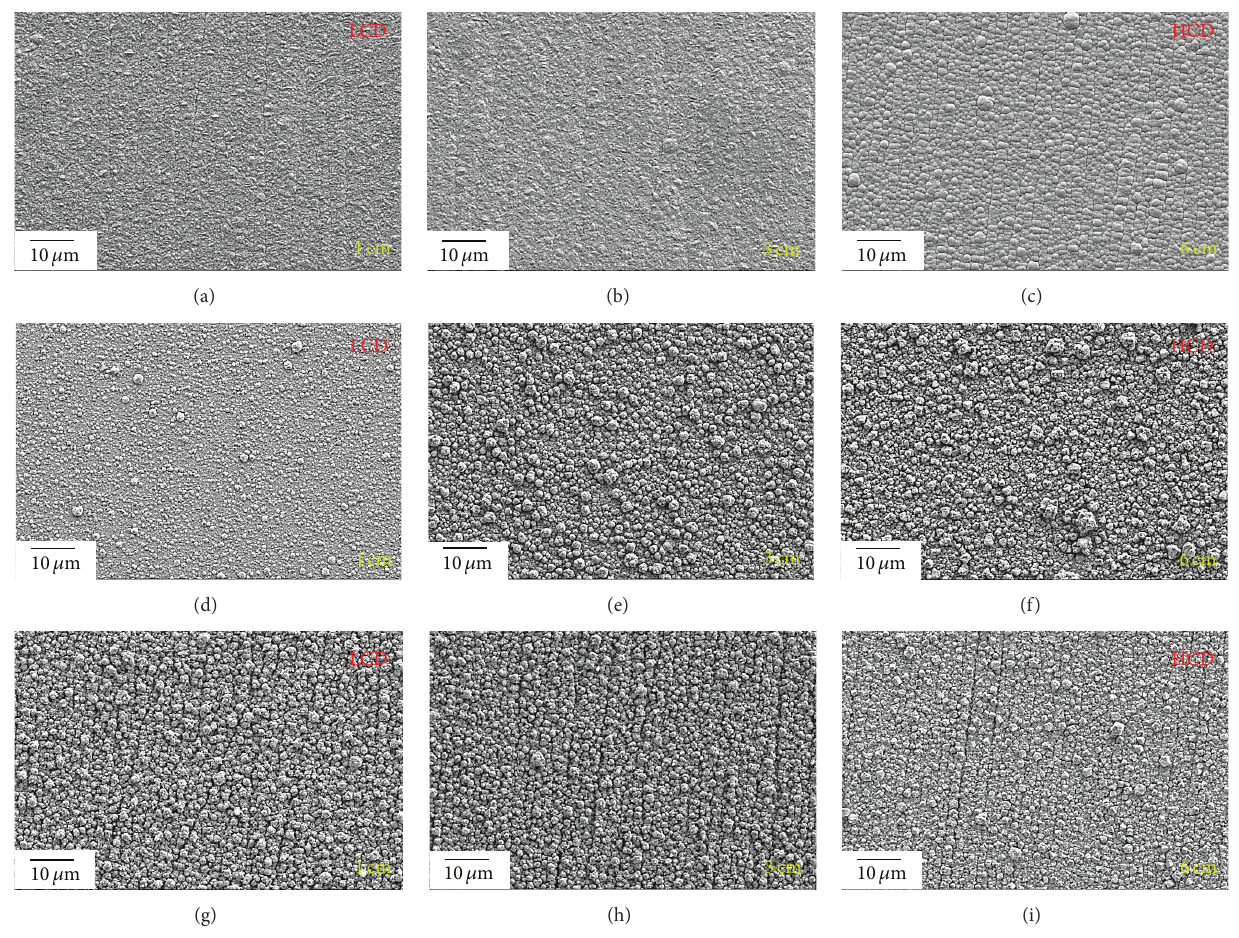
Figure 13: SEM micrographs taken at different regions on the substrate: 1cm, 3 cm, and 6cm showing the surface morphology of the electrodeposited Cu film fabricated at 2 mAcm −2 (a)–(c); 4.1mAcm −2 (d)–(f); and 8.2 mAcm −2